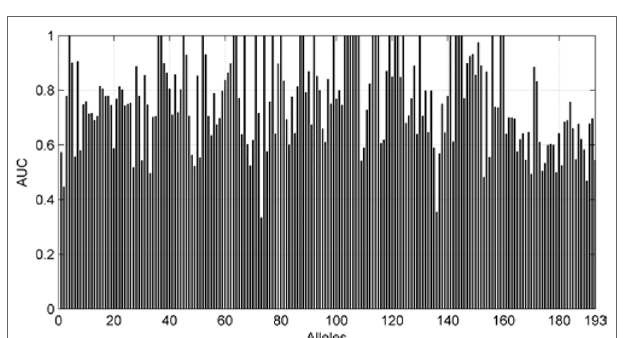
FIgURe 8 | AUC of each allele.